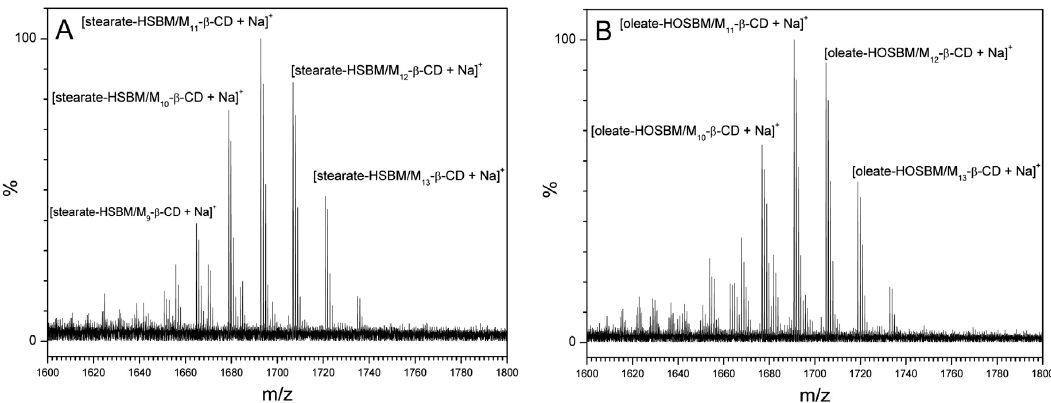
Figure 18. ESI mass spectra of H-SBM/M- β -CD ( A ) and HO-SBM/M- β -CD ( B ) inclusion complexes. Reprinted from [32]. Copyright (2018), with permission from Elsevier.